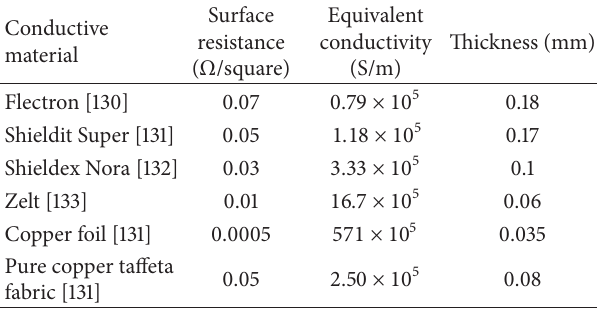
Table 3: Conductive textiles